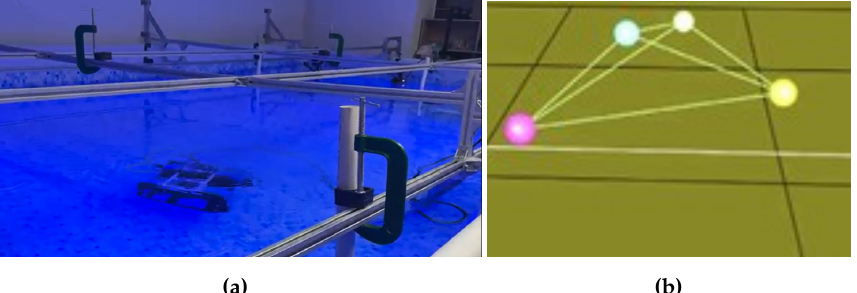
Figure 18. ( a ) The motion capture system in operations; ( b ) The rigid frame built on reflective markers.